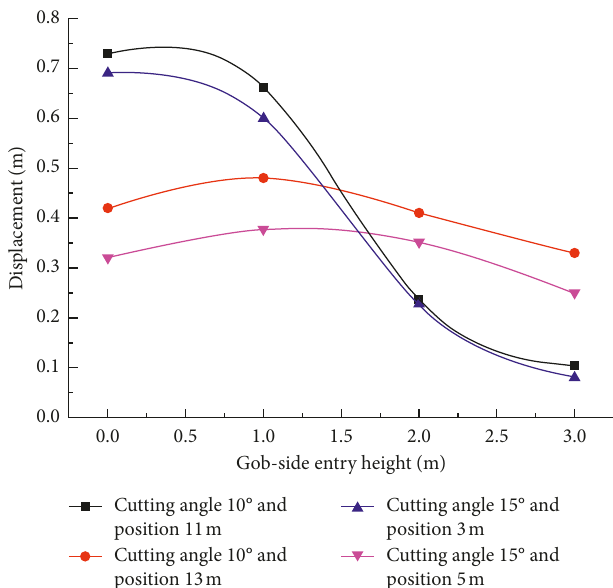
Figure 11: Displacement variation of coal side of GSER before and after the THAS